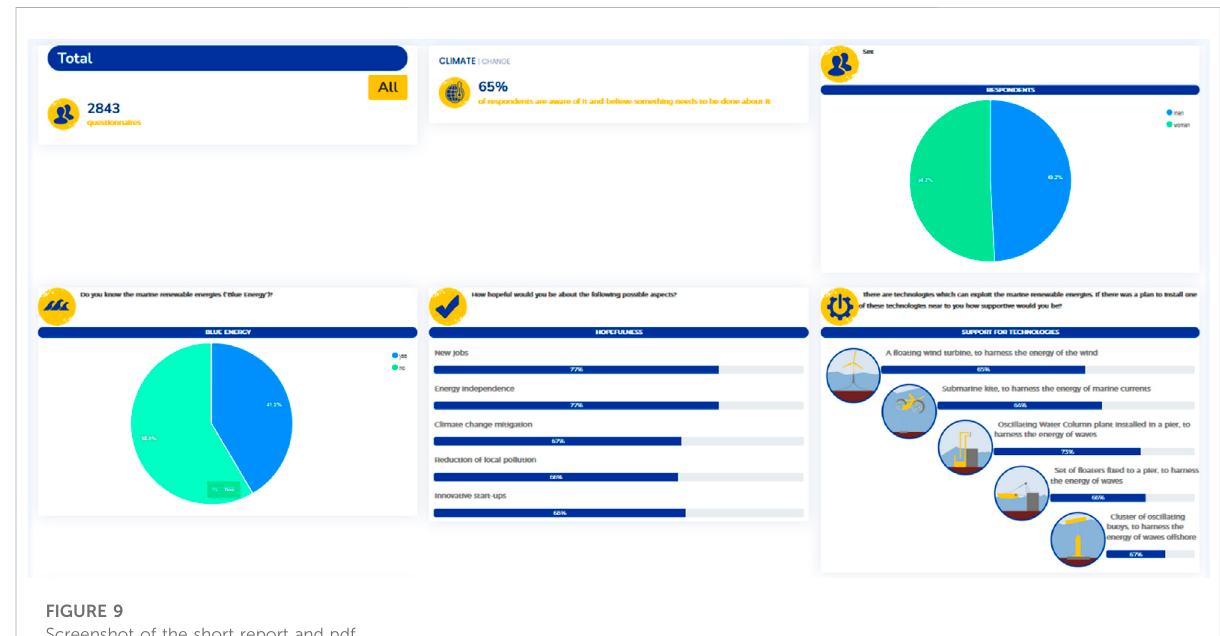
FIGURE 9 Screenshot of the short report and pdf.